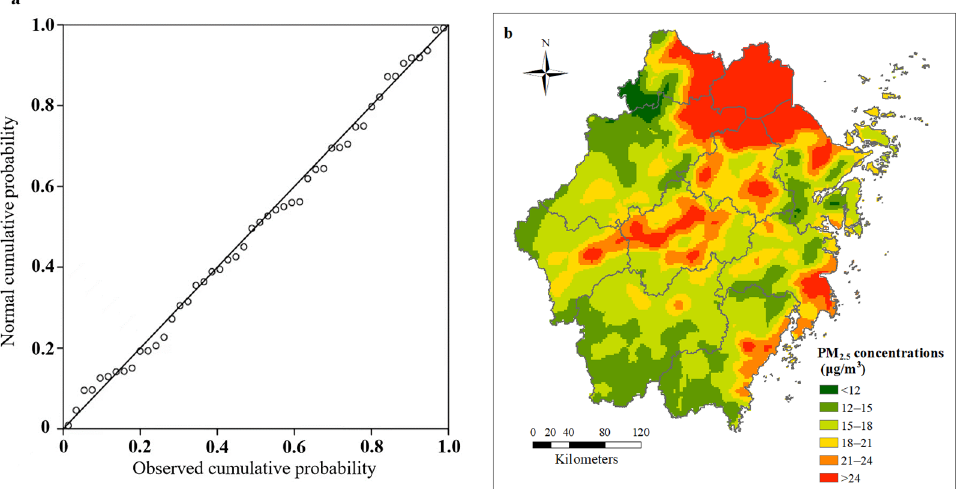
Figure 5. ( a ) Standardized residual P-P plot. ( b ) Simulation results of the GWR-based improved land use regression (LUR) model.